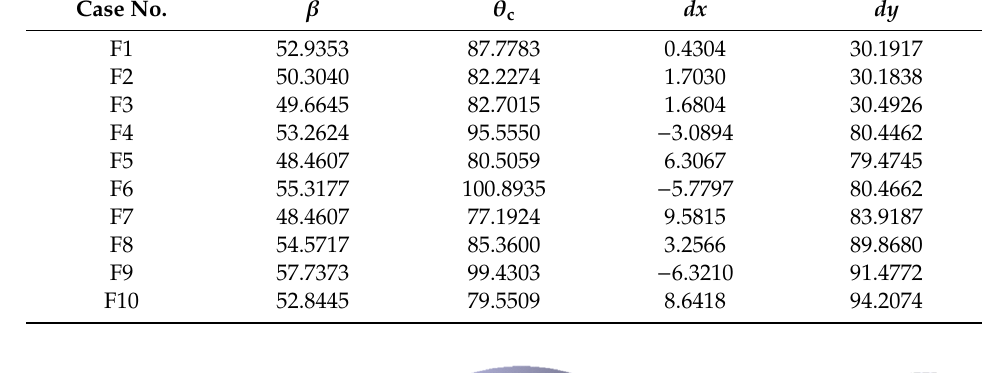
Figure 7. Comparisons with various algorithms: ( a ) the grinding errors; ( b ) the computing time.